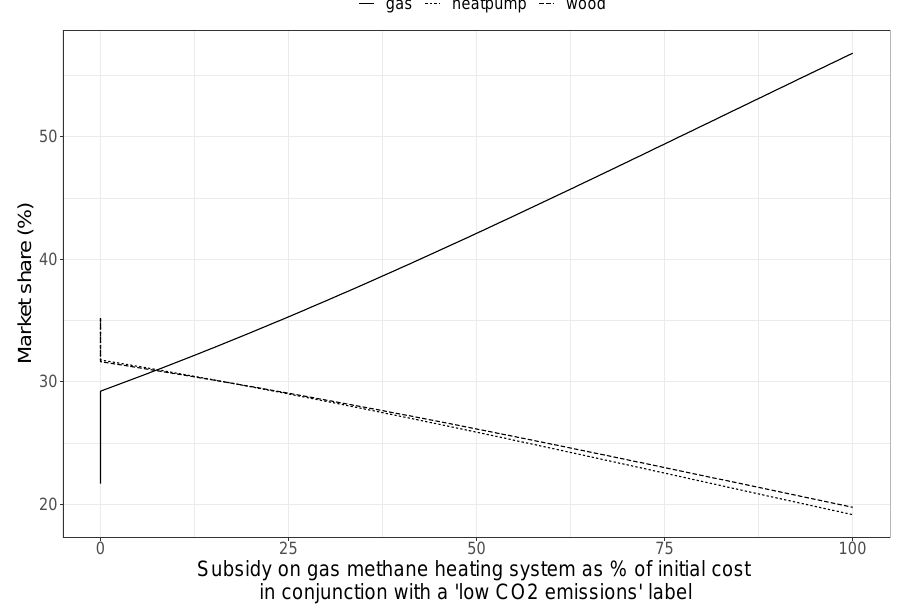
Figure 7. Simulation 2: MNL simulation on market share change providing a subsidy and a ‘climate friendly’ label to natural